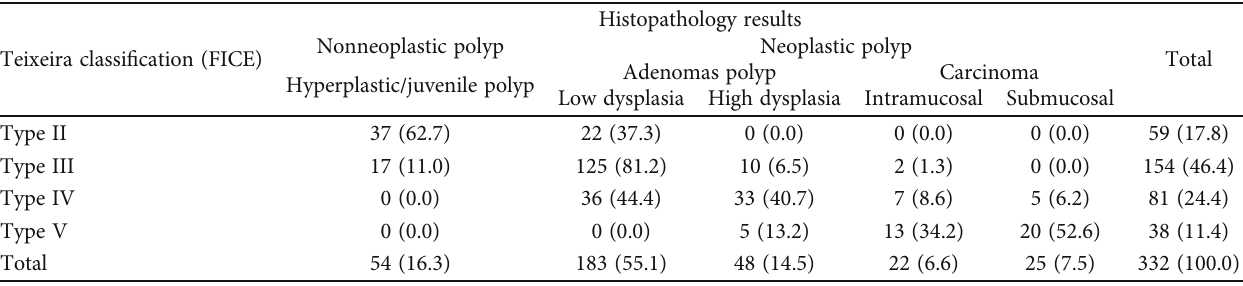
Table 2: Relationship between capillary-vessel pattern (Teixeira) classi fi cation of magnifying endoscopy with FICE and histopathology results ( n = 332 ).